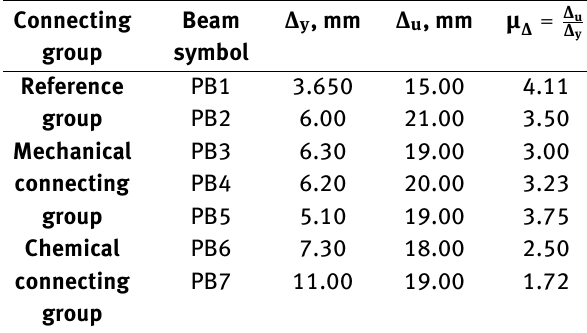
Table 4: Ductility index of tested composite beam